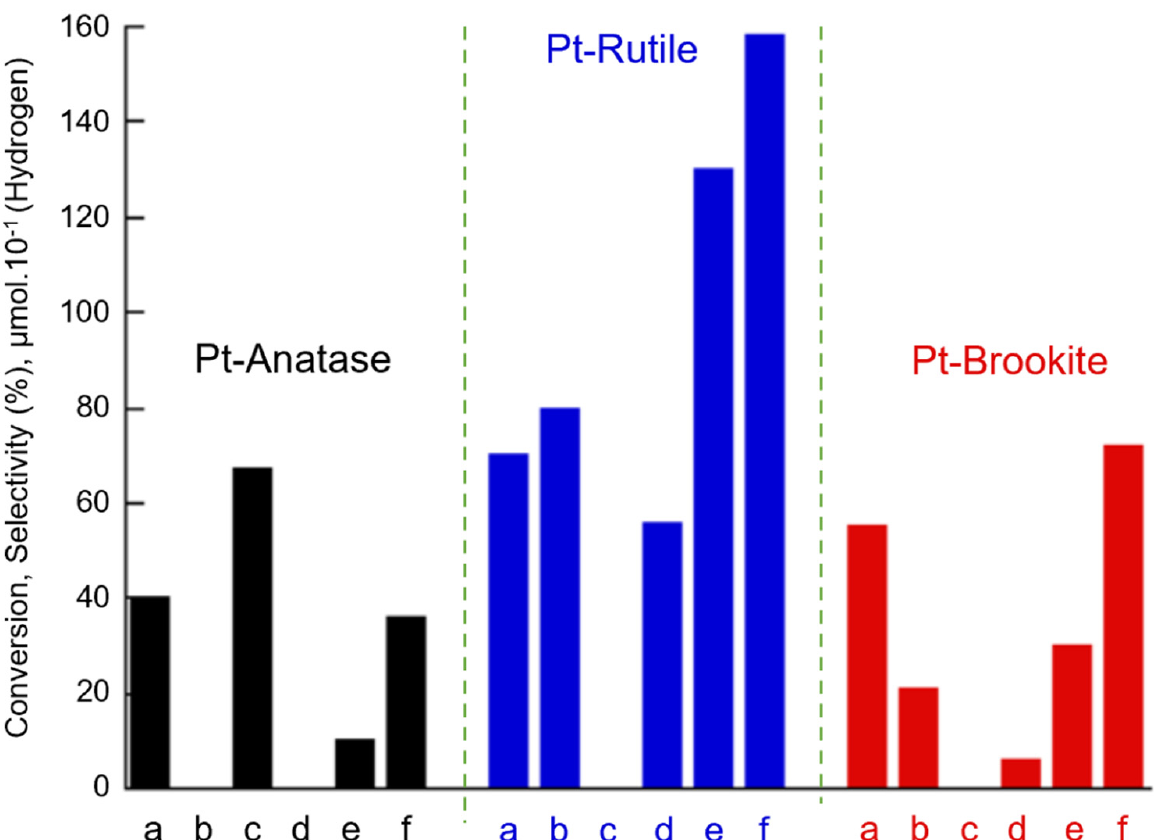
Figure 16. (a) Glucose conversion; (b) selectivity of arabinose, (c) selectivity of gluconic acid, (d) selectivity of erythrose, (e) selectivity of formic acid, and (f) amount of hydrogen obtained during the transformation in the presence of Pt-TiO 2 samples (anatase, rutile, brookite) [21,135]. Adapted with permission from Bentham Science Publishers Ltd., Mini-reviews in organic chemistry , Bellardita, M. et al., License Number: 1270489-1, 2020. Table 3 indicates the main products reported in the literature, the operating conditions,